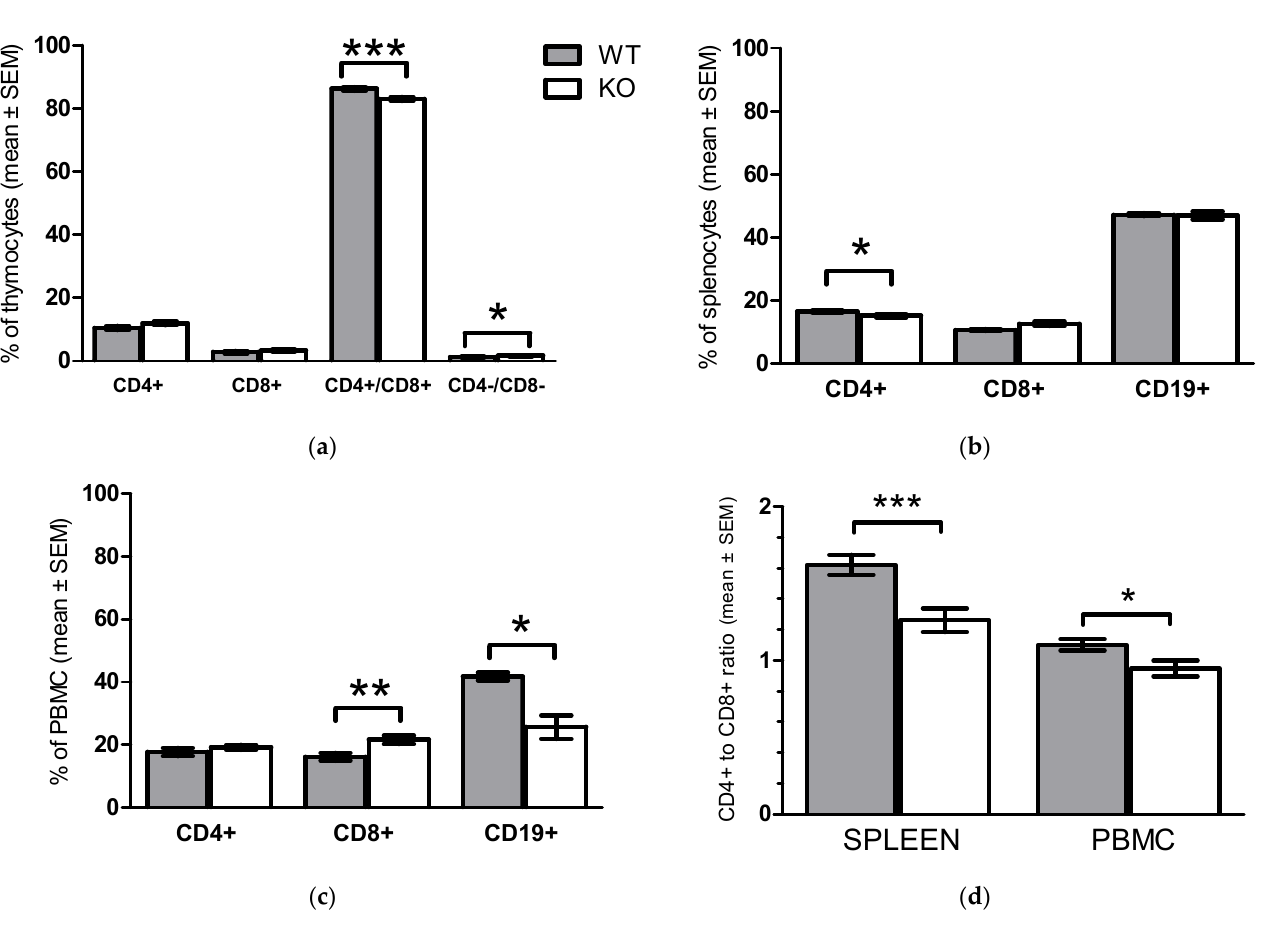
Figure 3. Phenotypic changes in functional KO mice. The percentage of CD4+, CD8+, CD4+/CD8+ or CD19+ mononuclear cells isolated from ( a ) thymus ( b ) spleen ( c ) peripheral blood is shown as comparison of wild type to functional KO mice. ( d ) Ratio of CD4+ T cells to CD8+ peripheral mononuclear cells purified from spleen or blood of WT and functional KO mice. Data are presented as mean ± SEM, ( a ) n = 7, ( b ) n = 4, ( c ) n = 3, ( d ) n = 8, * p < 0.05, ** p < 0.01, *** p < 0.001.